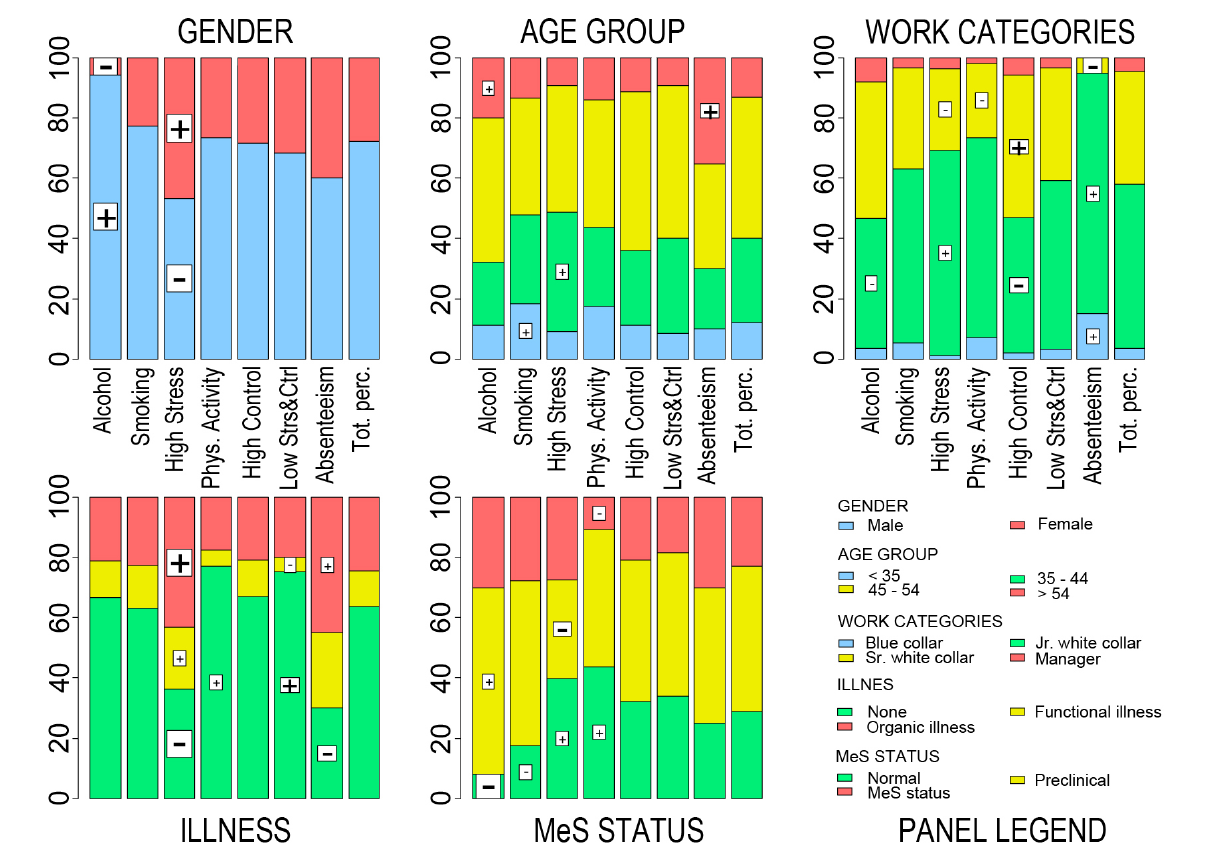
Figure 4. Barcharts of within-typology percentage distributions of personal data (gender, work categories, age group), illness status, and metabolic syndrome (MeS). Details regarding statistical symbols and significance are reported in Multimedia Appendix 1. (Phys = physical, Strs&Ctrl = stress and control; Tot. perc. = total percentage).